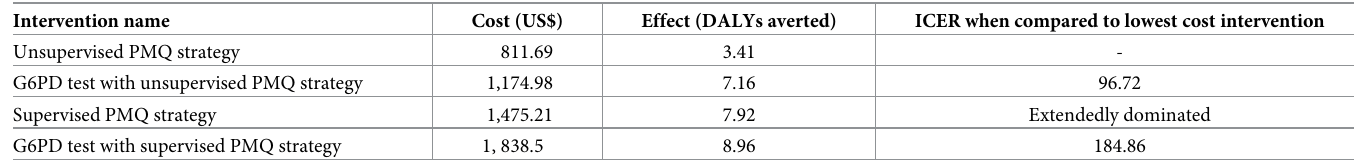
Table 4. Cost, effect and ICER from base case analysis, where each strategy was modelled for implementation at one health facility for one year. Intervention name